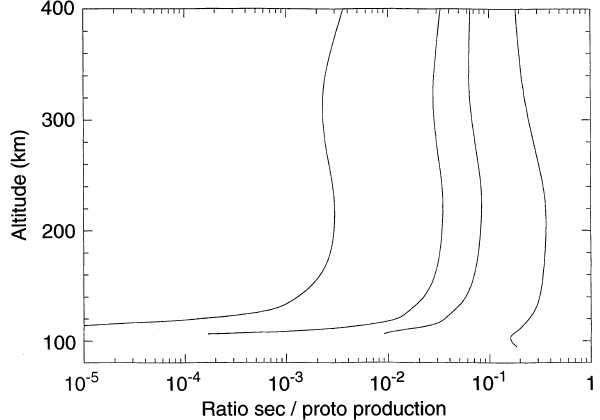
Fig. 7. The ratio between secondary electrons and primary proto- electrons versus height for four energies of input Maxwellian protons: 1 keV ( left ), 5 keV, 10 keV and 50 keV (